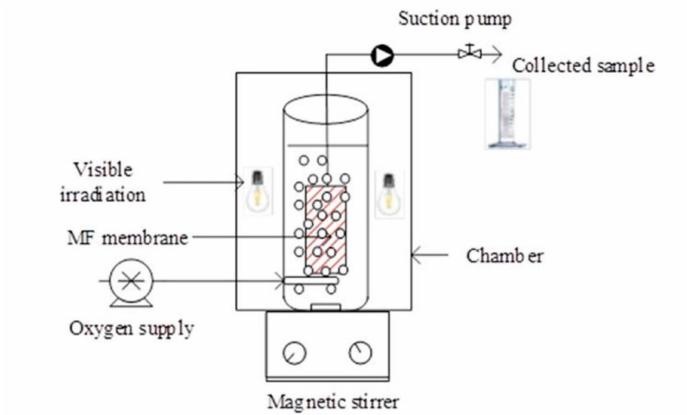
Figure 4. Submerged photocatalytic membrane reactor (SMPR) reactor set up